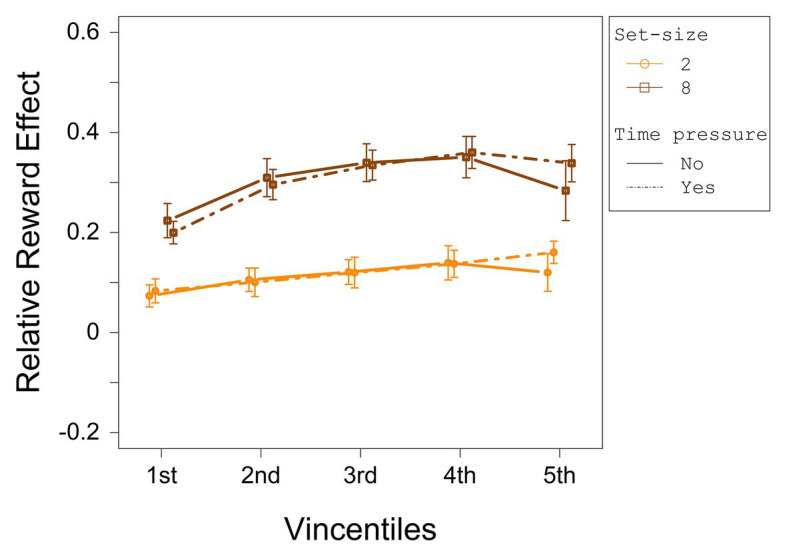
The relative reward effect depending on set-size and deadline for each vincentile in Experiment 1. Error bars represent 95% within-subject confidence intervals (Loftus and Masson, 1994; Morey, 2008).